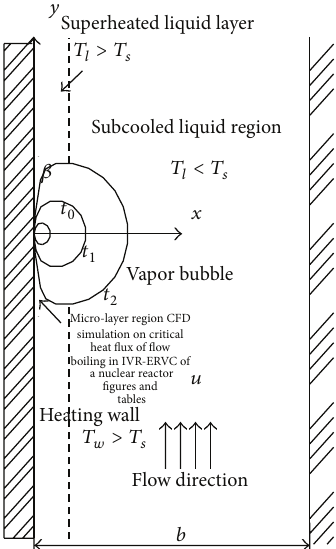
Figure 1: Schematic diagram of bubble growth